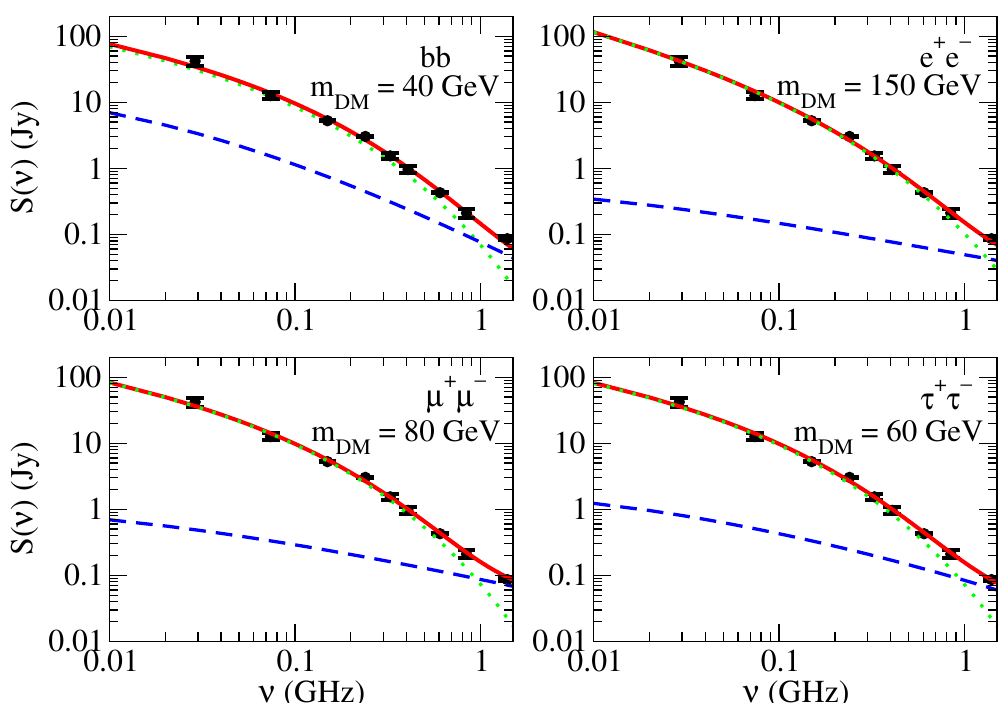
Figure 4. The best-fit dark matter scenario for the Abell 4038 cluster radio data [39]. The red solid line, green dotted line, and blue dashed line represent the total predicted radio flux S ( ν ) , the cosmic-ray contribution (adiabatic compression model), and the dark matter contribution, respectively. The data with error bars were extracted from